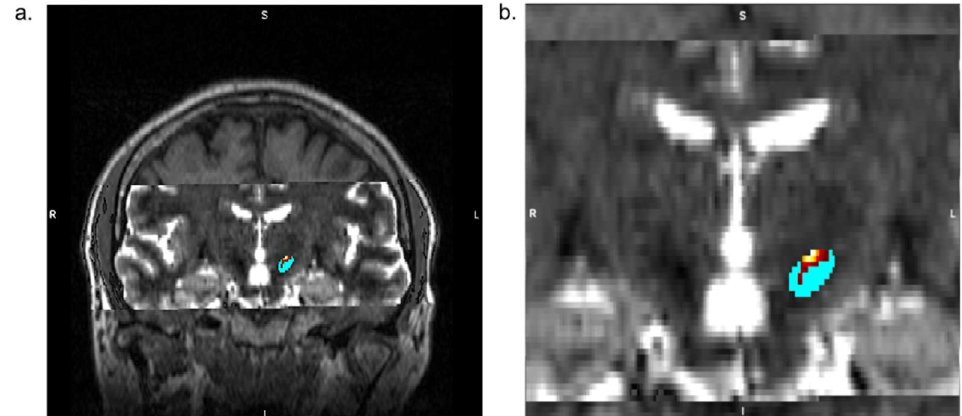
Figure 1. Example of STN parcellation: ( a ) Coronal view of T1-w MPRAGE overlaid by T2-w image with adjusted brightness and contrast to delineate STN. The light-blue colour indicates a segmented mask of STN, and the yellow-red colour indicates the motor part of STN identified by probabilistic tractography. ( b ) Zoomed detail to STN in relation to lateral ventricles.